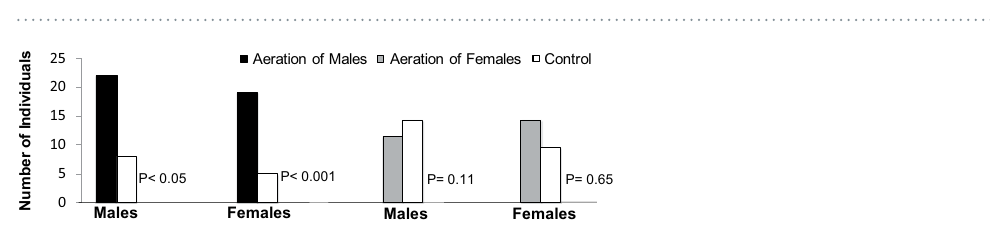
Figure 1. Total ion chromatograms of headspace extracts obtained from Homalinotus depressus males and females. 1 – 4 : male specific volatiles.